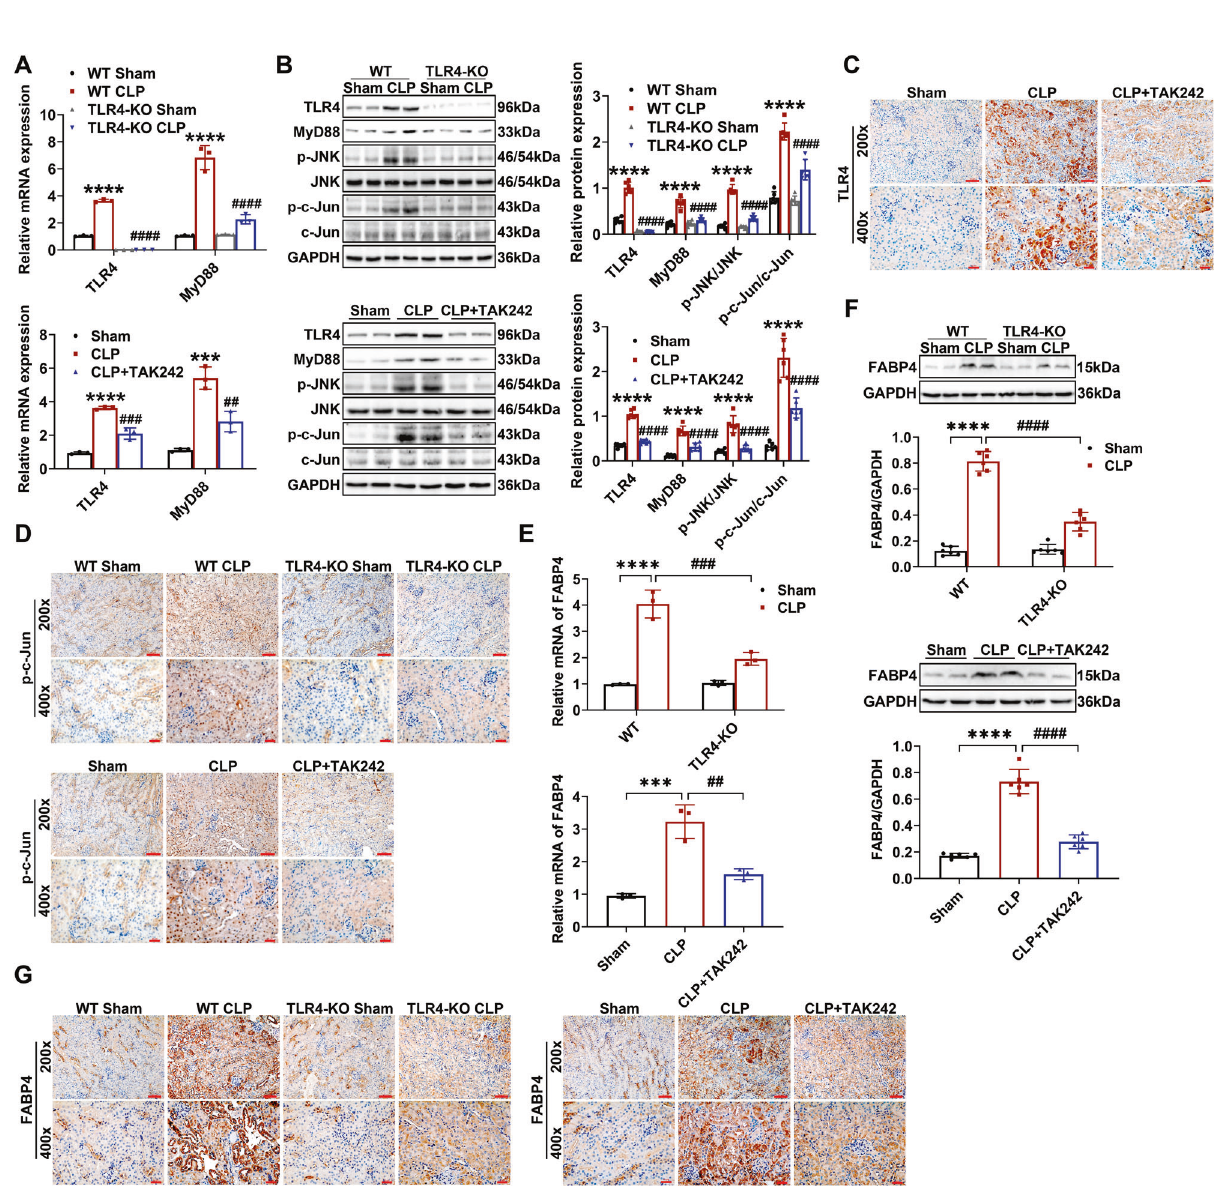
Fig. 4 CLP-induced upregulation of FABP4 was mediated by TLR4 signaling in injured kidneys. C57BL/6J, TLR4 inhibitor TAK242-treated C57BL/6J, TLR4 KO, and WT mice (male, 8-10 weeks old) were subjected to CLP or sham surgery and killed 16 h later. A Quantitative real-time PCR analysis of TLR4 and MyD88 in kidney tissues ( n = 3). B Western blot analysis of TLR4, MyD88, p-JNK, JNK, p-c-Jun, and c-Jun in the kidneys ( n = 6). Immunochemistry staining of ( C ) TLR4 and ( D ) p-c-Jun in kidney tissues (×200, scale bar = 50 μ m; ×400, scale bar = 20 μ m). E Quantitative real-time PCR analysis of FABP4 in renal tissues ( n = 3). F Western blot analysis of FABP4 in the kidneys ( n = 6). G Immunochemistry staining of FABP4 in kidney tissue sections (×200, scale bar = 50 μ m; ×400, scale bar = 20 μ m). Data are shown as mean ± SD; *** P < 0.001, **** P < 0.0001 for WT CLP versus WT Sham, or for CLP versus Sham; ## P < 0.01, ### P < 0.001, #### P < 0.0001 for TLR4-KO CLP versus WT CLP, or for CLP + TAK242 versus CLP. Cell Death and Disease (2022)